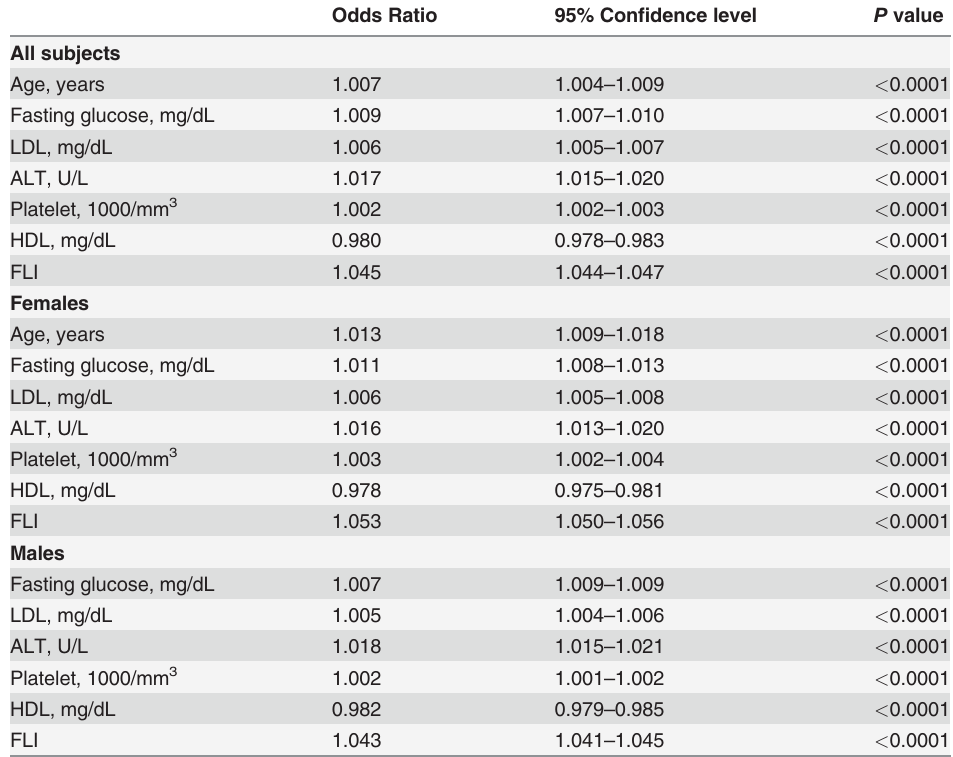
Table 2. Factors associated with ultrasonogrphic fatty liver in different populations by multivariate analysis in model I. Odds Ratio 95% Con fi dence